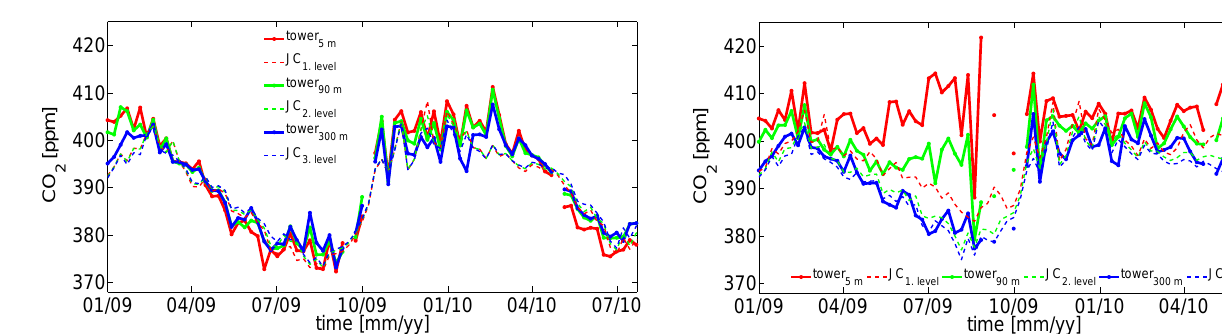
Fig. 8. The Jena CO 2 inversion at levels corresponding to the tall tower levels in comparison with the tall tower data (5m, 90m, 300m). Weekly averages of daytime measurements between 12:00p . m . and 03:00p . m . are compared. The Jena CO 2 inversion captures the seasonal cycle at all three levels, but slightly underes- timates the CO 2 concentration at all levels. Mean differences for all levels are given in Table 1. Table 1. Mean differences between model data and tall tower mea- surements. altitude